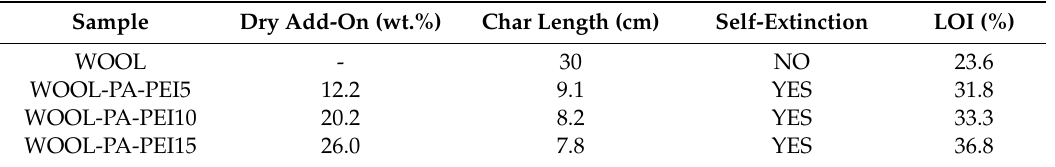
Table 17. Results from vertical flame spread and LOI tests for wool before and after the treatments with the polyelectrolyte complex. Sample Dry Add-On (wt.%)